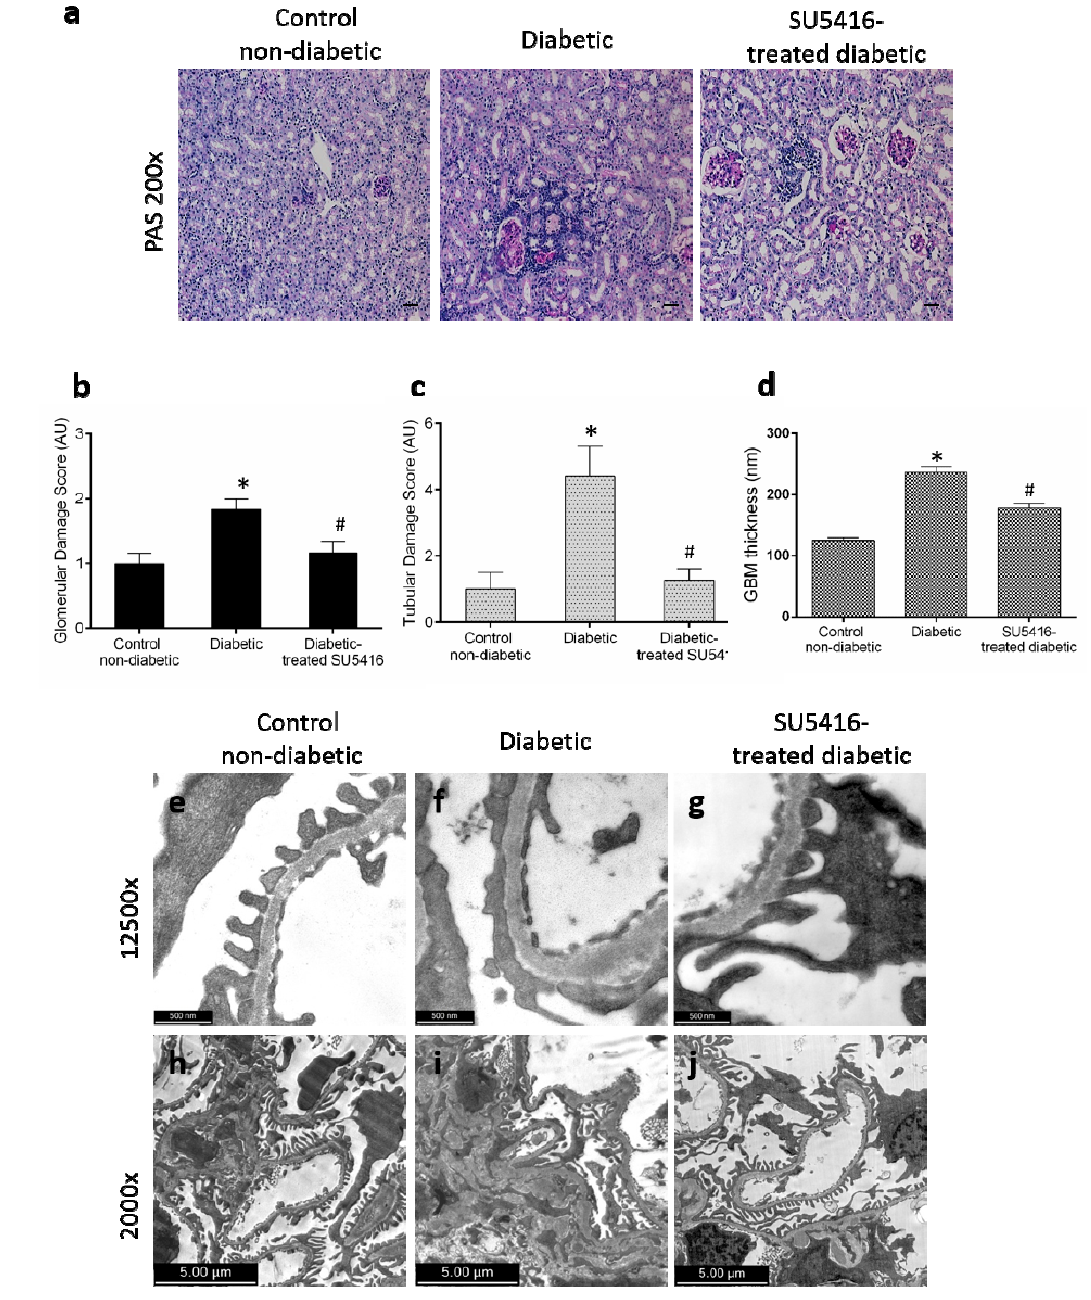
Figure 3. Effect of the blockade of VEGFR2 on renal lesions in a BTBR ob/ob experimental model. The BTBR ob/ob mice were treated with the VEGFR2 kinase inhibitor SU5416 (i.p, 0.1 mg/mouse, 3 times a week) (SU5416-treated diabetic group) or vehicle-treated mice (diabetic group), starting at 15 weeks and followed until 20 weeks. Renal lesions were evaluated at 20 weeks in paraffin-embedded tissue sections. ( a ) Representative images of light microscopy of kidney sections in each group stained with periodic acid–Schiff (PAS). Magnification: ×200. Bars = 20 µm. ( b ) Quantification of glomerular and ( c ) tubular damage. ( d ) The quantitative measure of glomerular basement membrane (GBM) thickness. Electron micrographs of glomeruli of representative animals for ( e , h ) control mice, ( f , i ) diabetic mice and ( g , j ) SU5416-treated diabetic mice ( e – g ) 1 µm, magnification ×12,500 and ( h – j ) 2 µm, magnification ×2000. Data as mean ± SEM of 6–8 mice per group. * p < 0.05 versus control non-diabetic, # p < 0.05 versus diabetic.